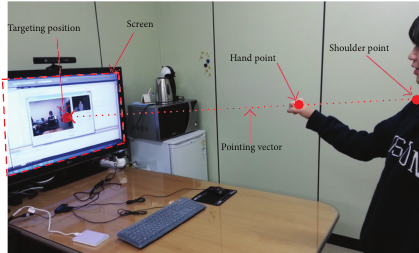
Figure 4: Conceptual diagram for representing the pointing vector and targeting position